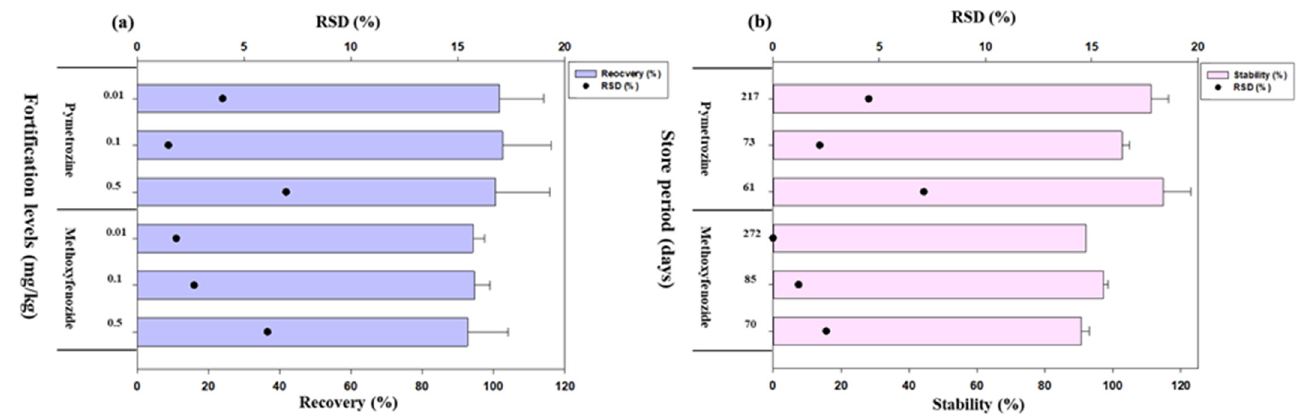
Figure 1. ( a ) Recoveries (%) and RSD (%) under different fortification levels (mg/kg) and ( b ) storage stabilities (%) and RSD (%) for different store period (days) at below − 20 °C observed for methoxyfenozide and pymetrozine in Chinese cabbage.